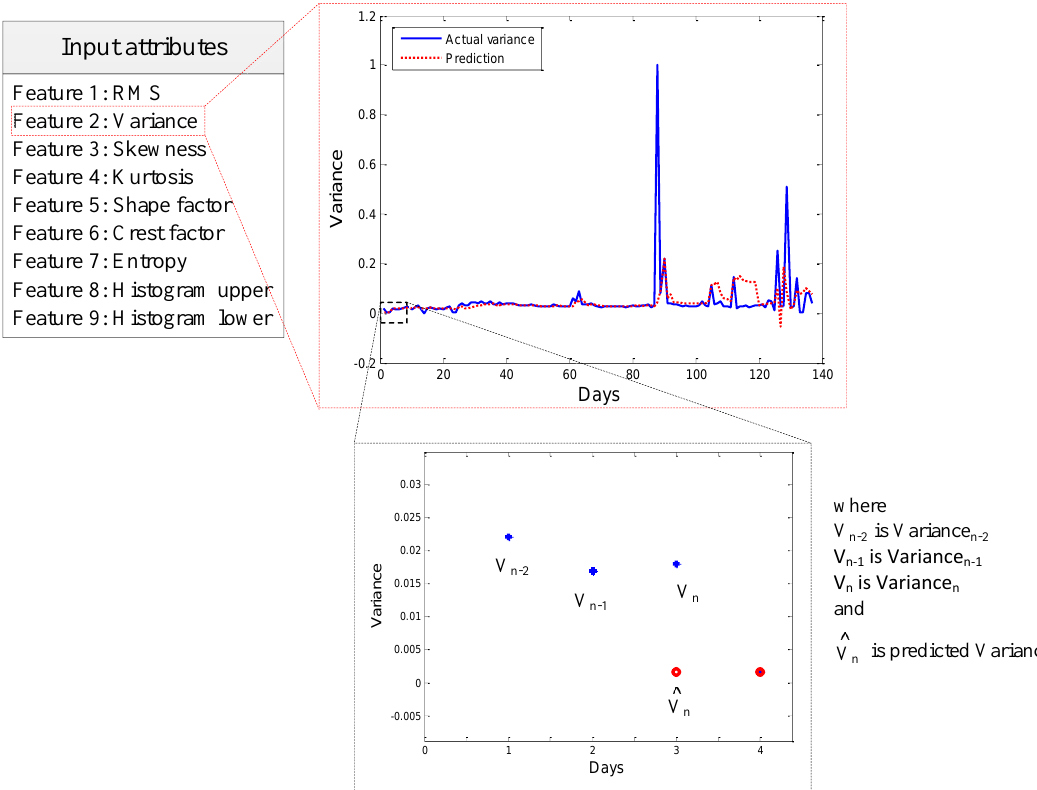
Figure 9. A schematic diagram of time series mode prediction.